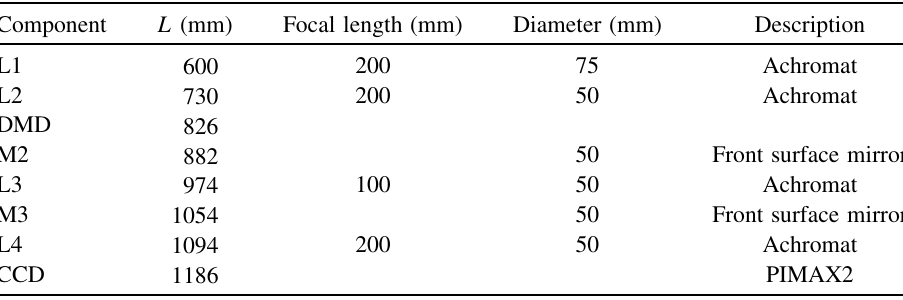
TABLE I. Parameters of UMER optical component.